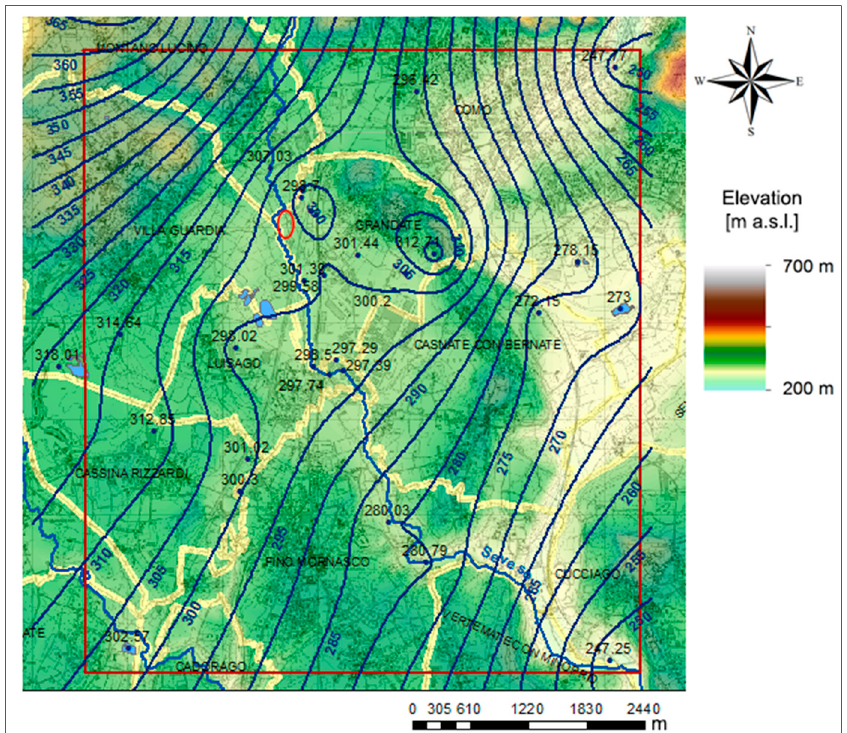
Figure 4. Piezometric map of the first aquifer and measured points with their groundwater level (head expressed in m a.s.l.). Encircled in red is the zone that was flooded in 2014. Piezometric lines 305 m